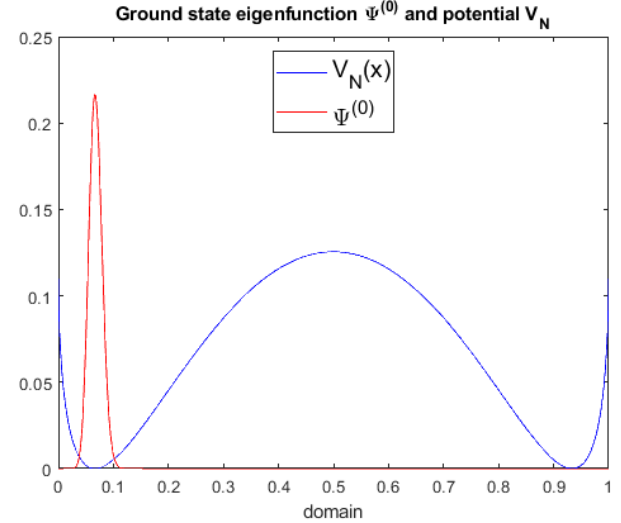
Figure 5: Scaled potential V and the ground state eigenfunction corresponding : = ˜ V N N / N for N = 1000 on the unit interval [ 0,1 ] , plotted on uniform grid points. to J N + 1 The potential is shifted so that its minimum is zero, and is plotted on the grid points x corresponding to the solution of y = D ( x ) / L, as explained in the main text.